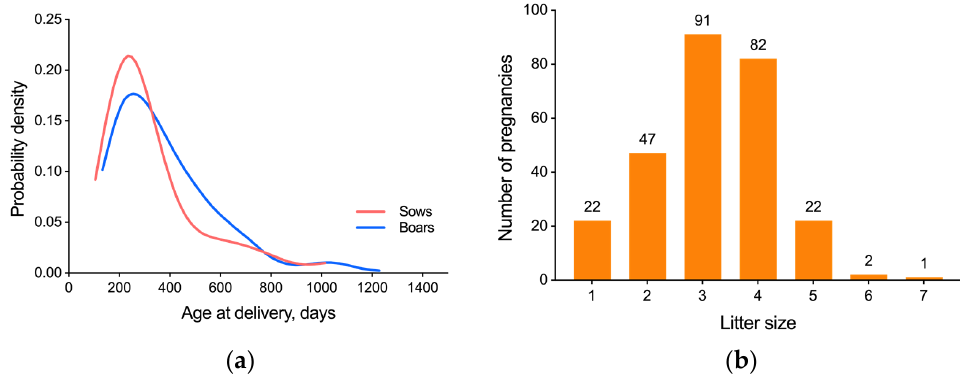
Figure 1. Overview of strain 13/N guinea pig colony, showing the parental breeding age and litter size. ( a ) Kernel Density Estimation for Age at Delivery for sows ( n = 266) and boars ( n = 260). ( b ) Distribution of number of fetuses in the dataset, from pregnancies yielding viable pups ( n = 267). To further characterize breeding outcomes in our colony by age at delivery, the breed- ing population was investigated by using three broad age categories, as previously de- scribed for strain 13/N guinea pigs [30]: 0 through 150 d for juveniles, 151 through 900 d for adults, and older than 900 d for geriatric adults (Tables 1 and 2). Table 1. Total fetus count and 10 day survival rate in strain 13/N guinea pig pregnancies by sow and boar age at